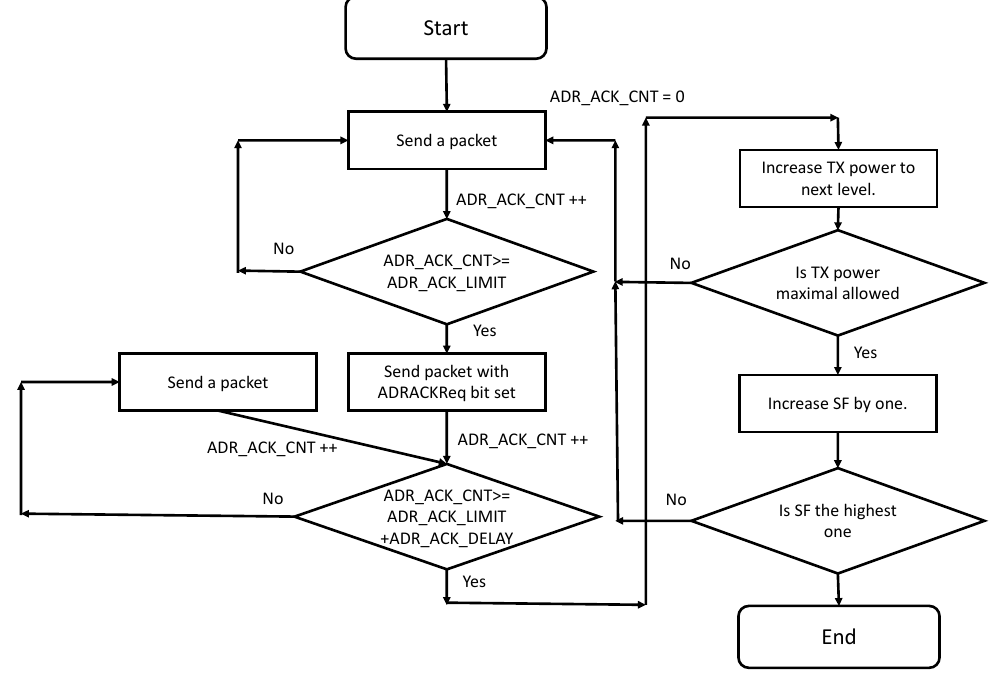
Figure 4. ADR mechanism algorithm implemented in the end